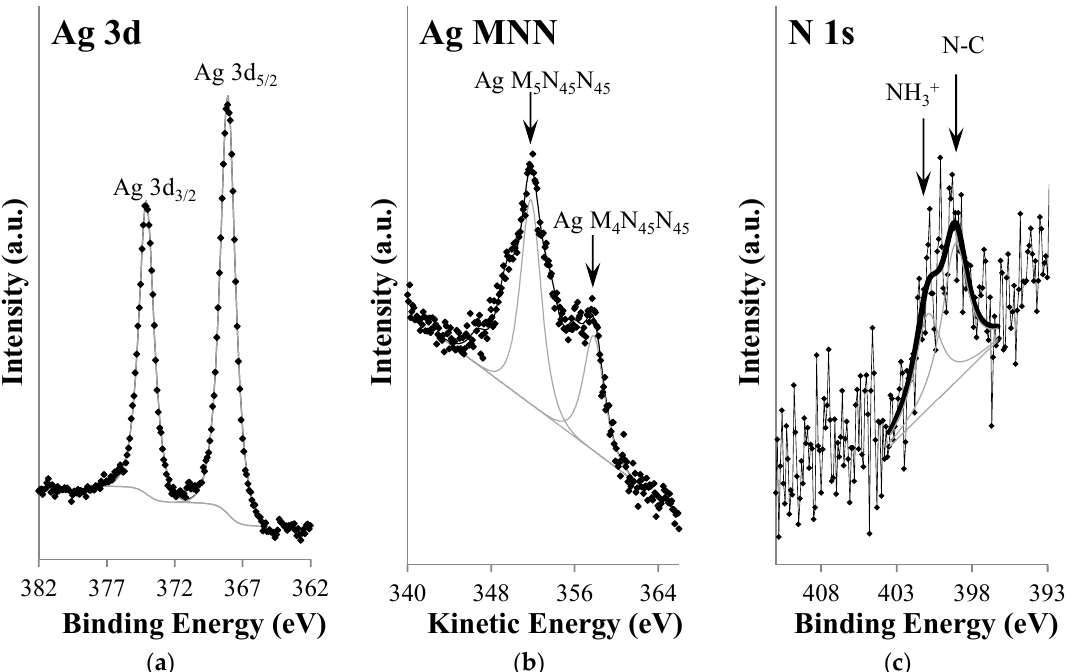
Figure 3. X-ray photoelectron spectroscopy (XPS) regions: ( a ) Ag 3d; ( b ) Ag MNN; and ( c ) N 1s.